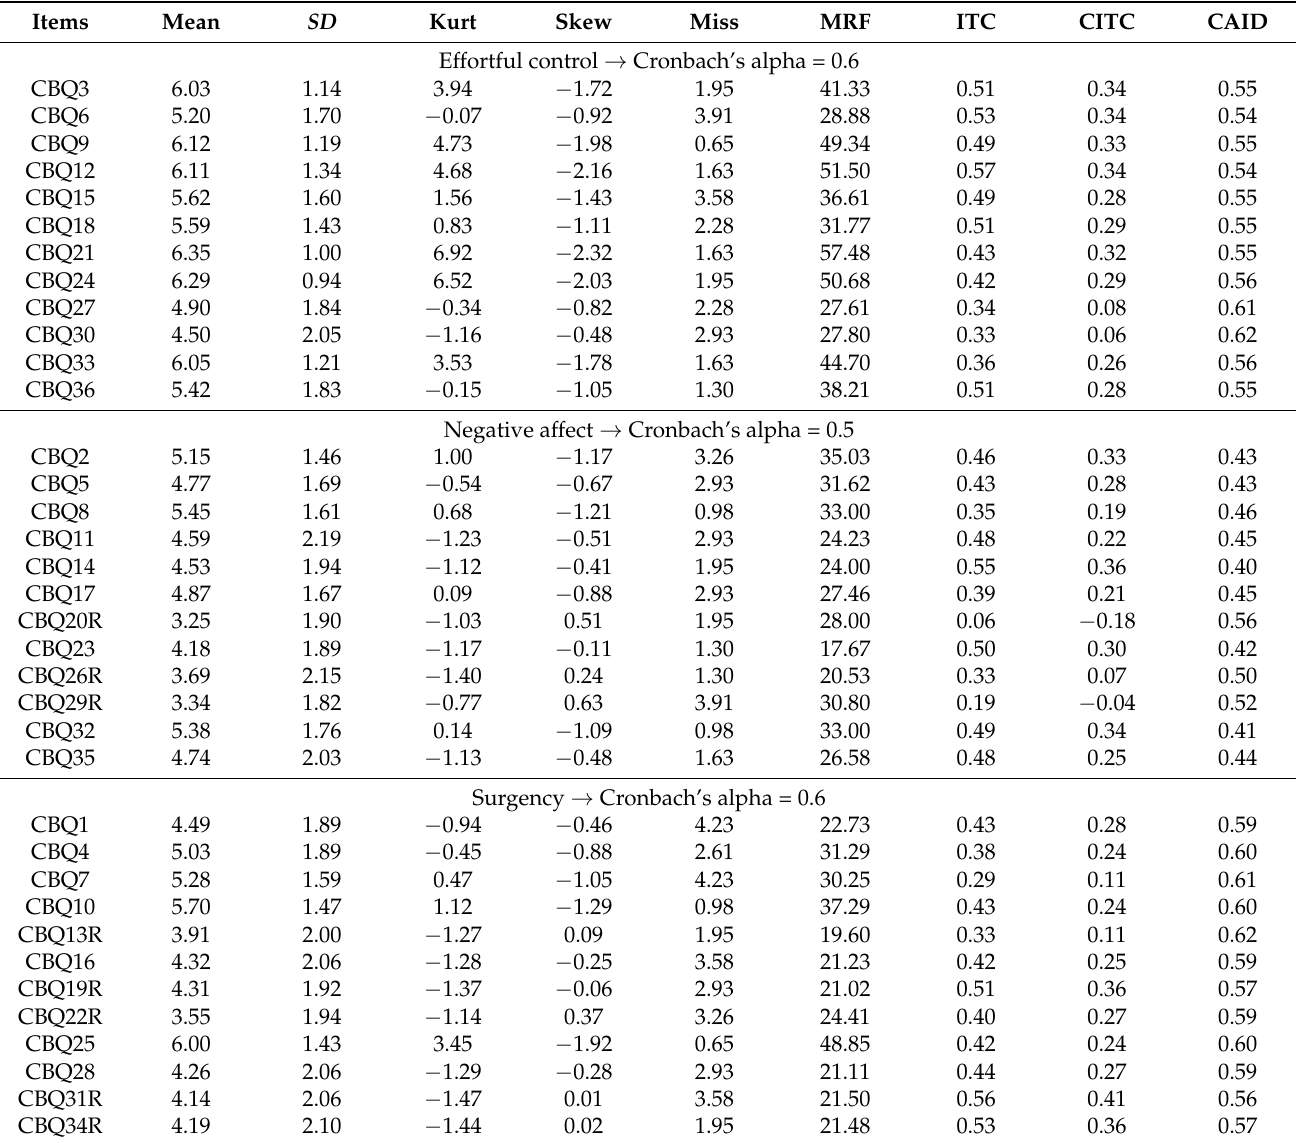
Table 2. Descriptive statistics and classical test theory indices of CBQ-VSF, raw data ( N =